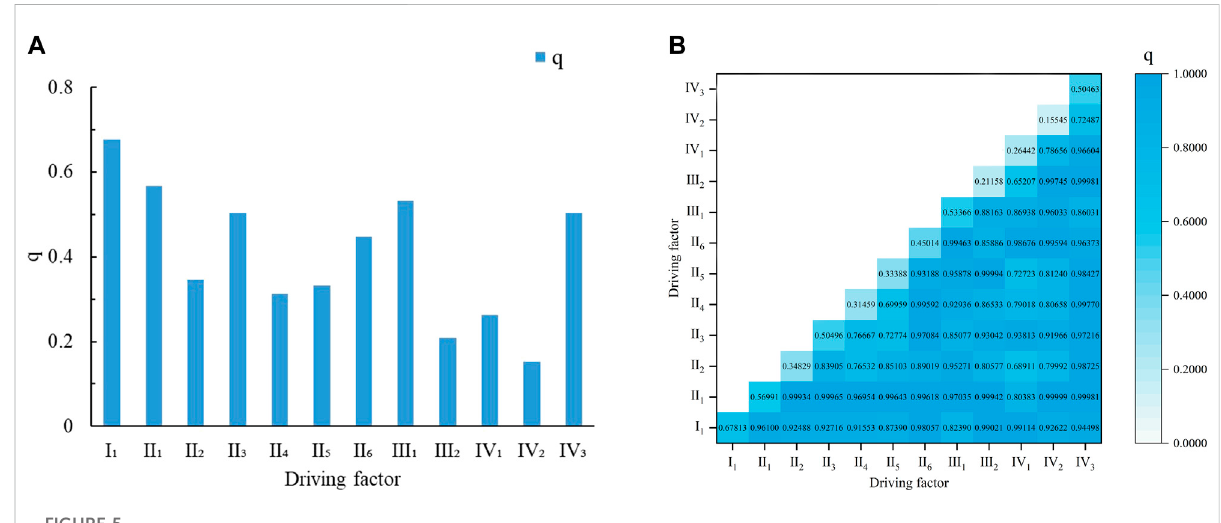
FIGURE 5 (A) is the result of factor detector. (B) is the result of the interaction